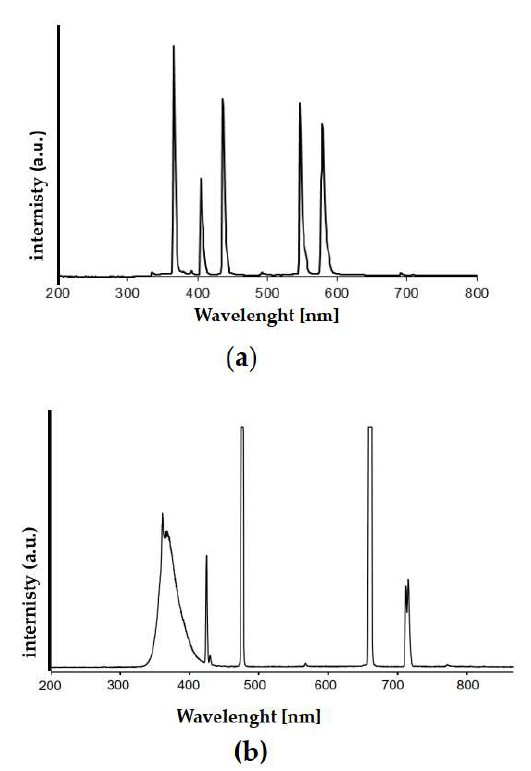
Figure 5. Emission spectra of UV / vis lamps used for the investigation of titania photoactivity on: ( a ) Oxidative decomposition of acetic acid, and ( b ) human breast cancer cells.